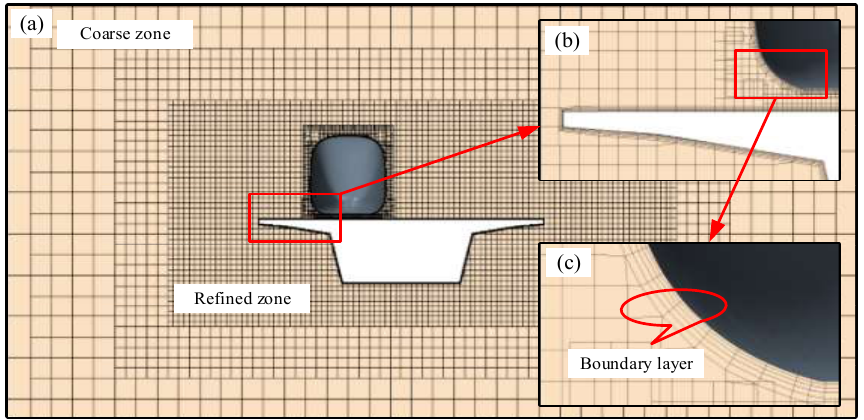
Figure 2. View of mesh distribution around train and bridge: ( a ) general mesh distribution; ( b ) refined mesh; ( c ) boundary layer mesh.